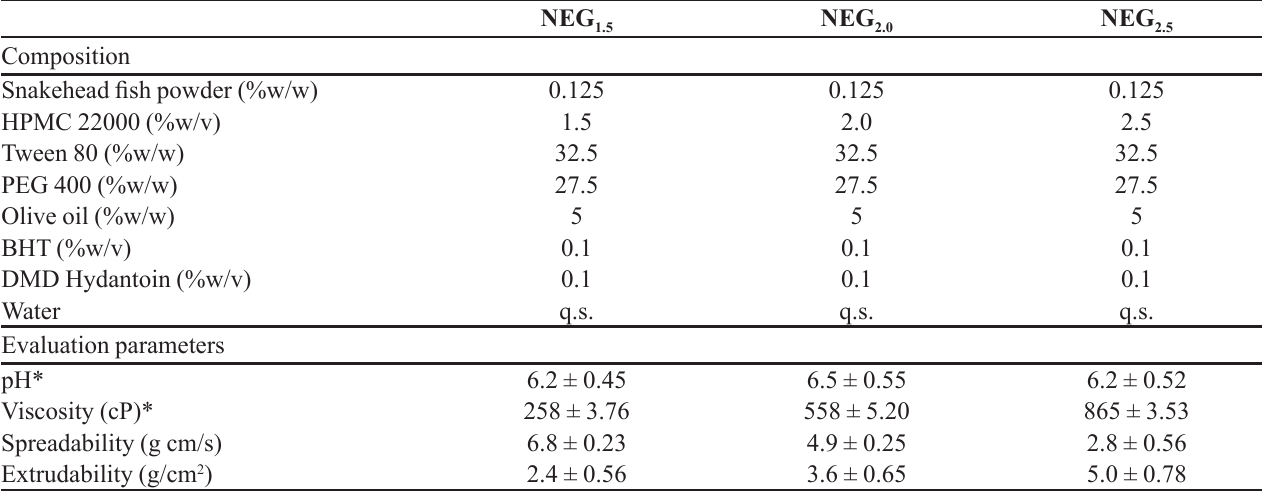
TABLE VI - Composition and evaluation parameters of